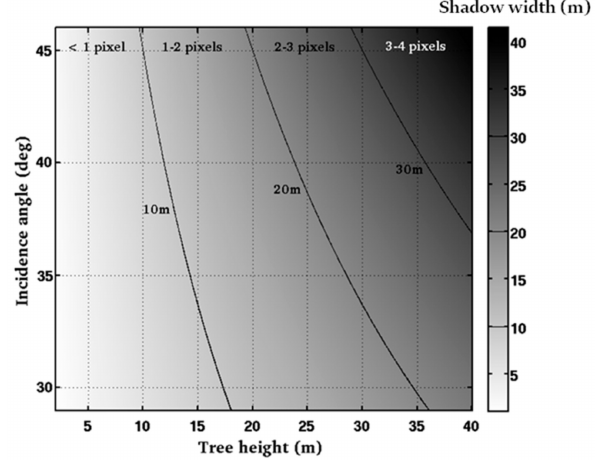
Figure 7. Shadow width as a function of tree height and Sentinel-1 incidence angle. The corresponding number of pixels is based on a 10 m pixel